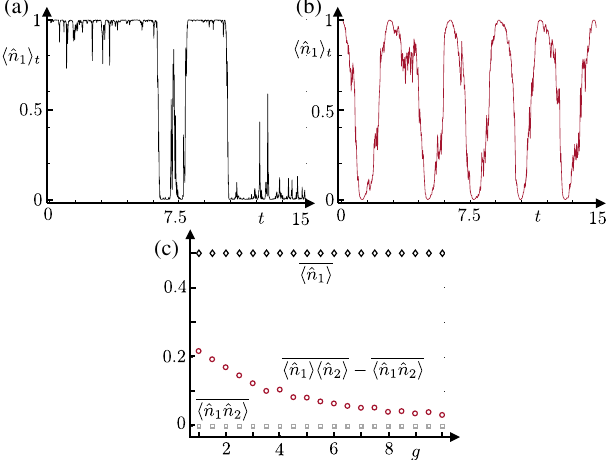
FIG. 1. Illustration of competing Hamilton and measurement dynamics in the two-site toy model. (a),(b) Single trajectory dynamics. (a) For strong monitoring g ¼ 10 , the system is pinned to dark states for most of the time, with weak, short-time fluctuations. (b) A dominant Hamilton dynamics ( g ¼ 0 . 5 ) leads to depinning, with almost no time spent in the dark states. (c) Trajectory averaged correlation functions. Quantities linear in the state are insensitive to the competition ratio, while the correlation function nonlinear in the state witnesses a monitoring dependence, which develops a nonanalytic behavior in the thermodynamic